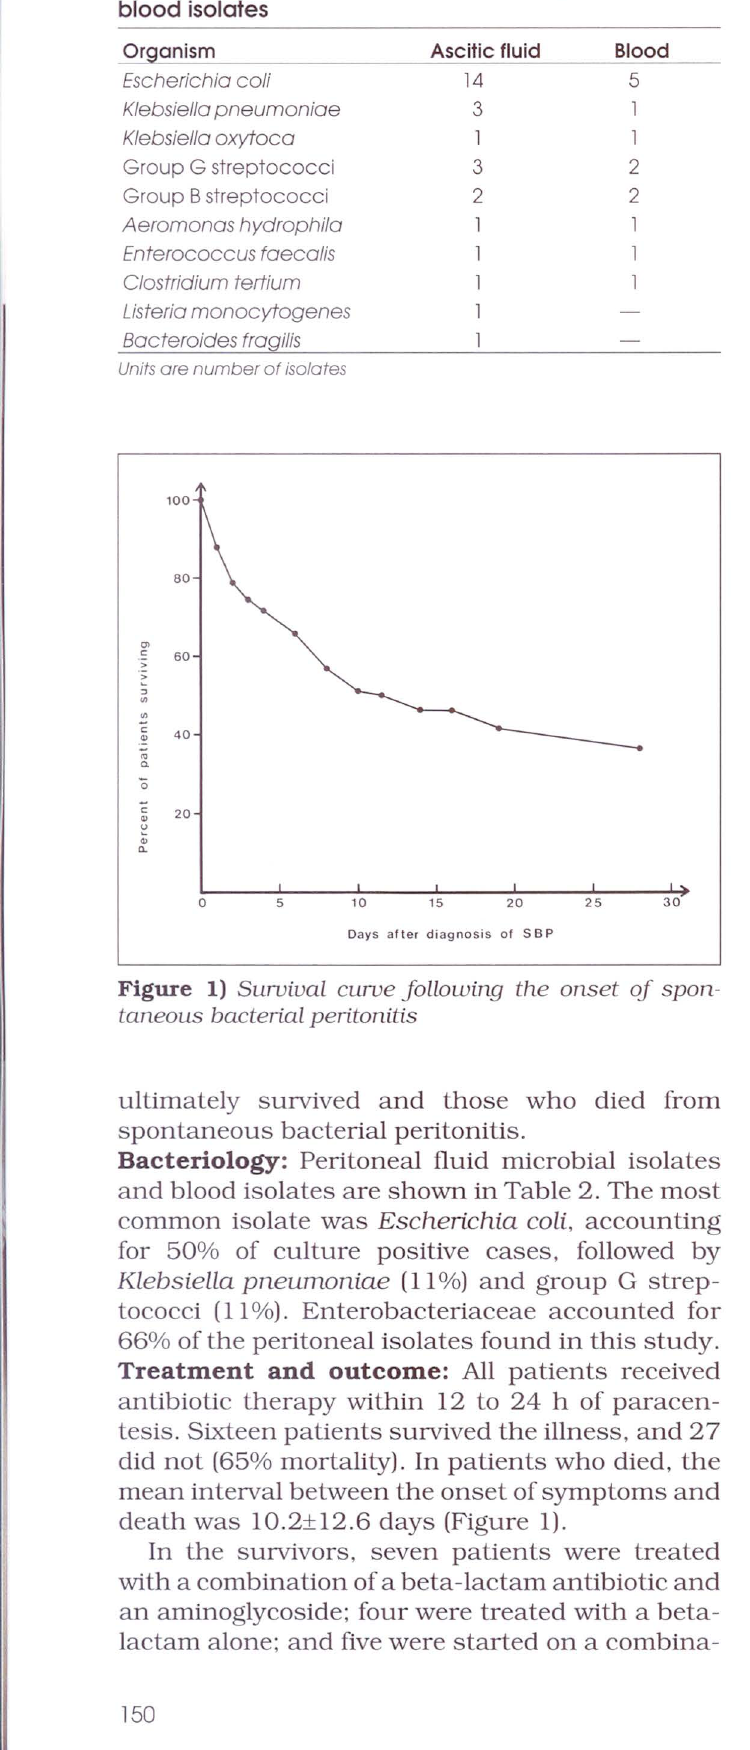
Bacteriology of spontaneous bacterial peritonitis and blood isolates